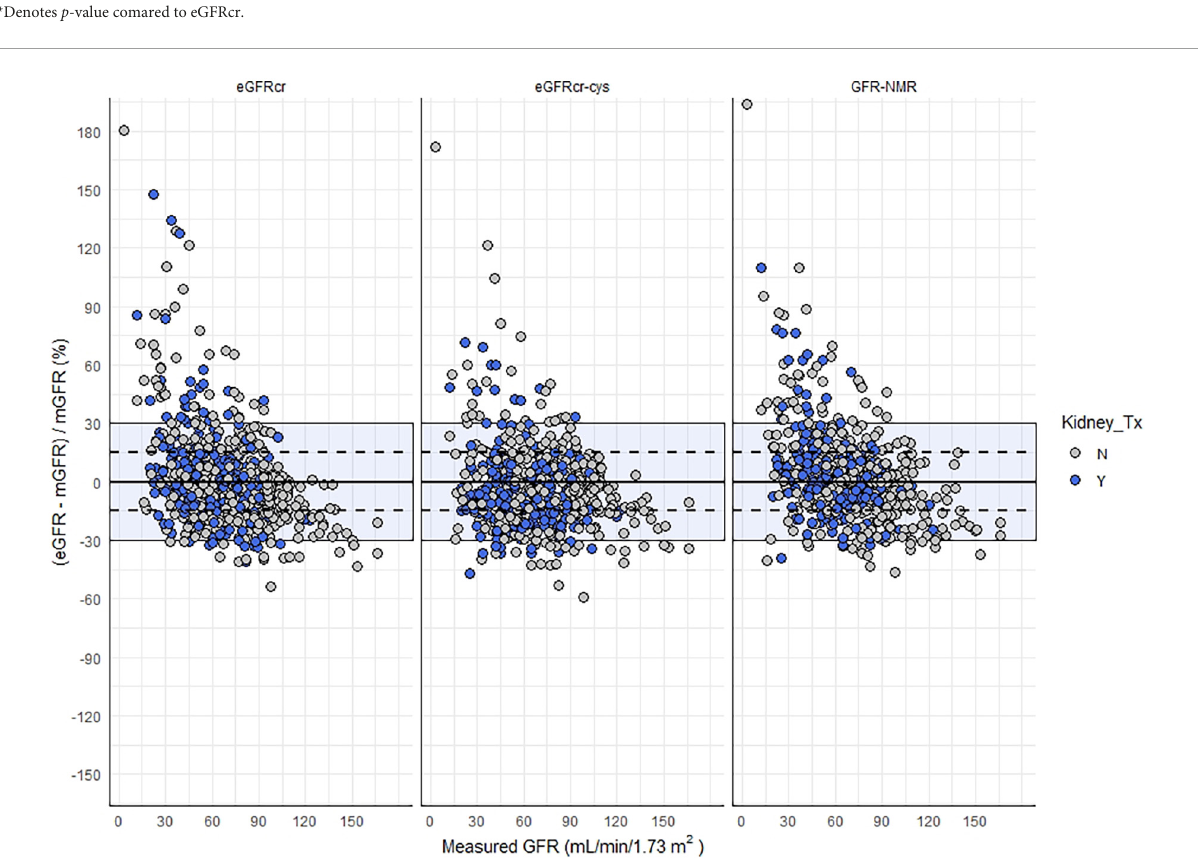
FIGURE2 Relative difference between eGFR and mGFR as a function eGFR method and kidney transplant status. Shaded area indicates eGFR values within 30% of mGFR, and the dashed lines represent values within 15% of